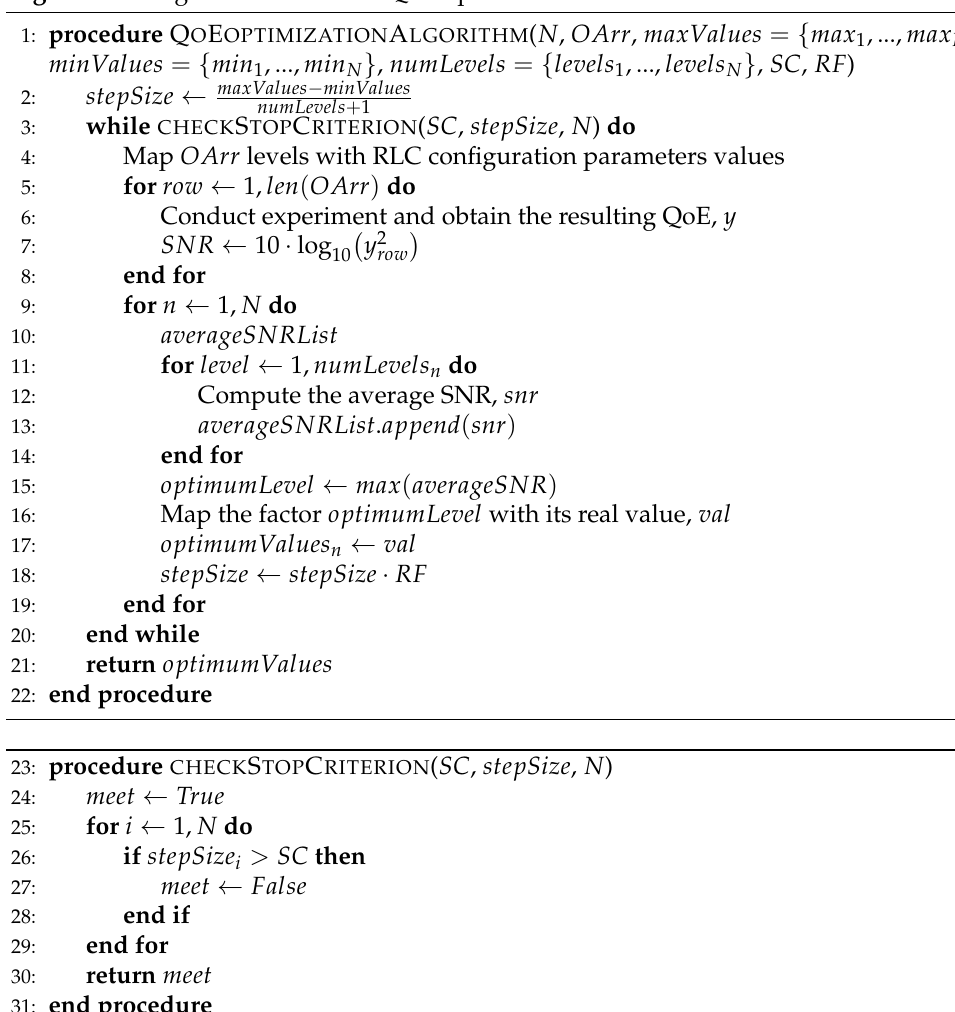
Algorithm 1 Taguchi’s method for QoE